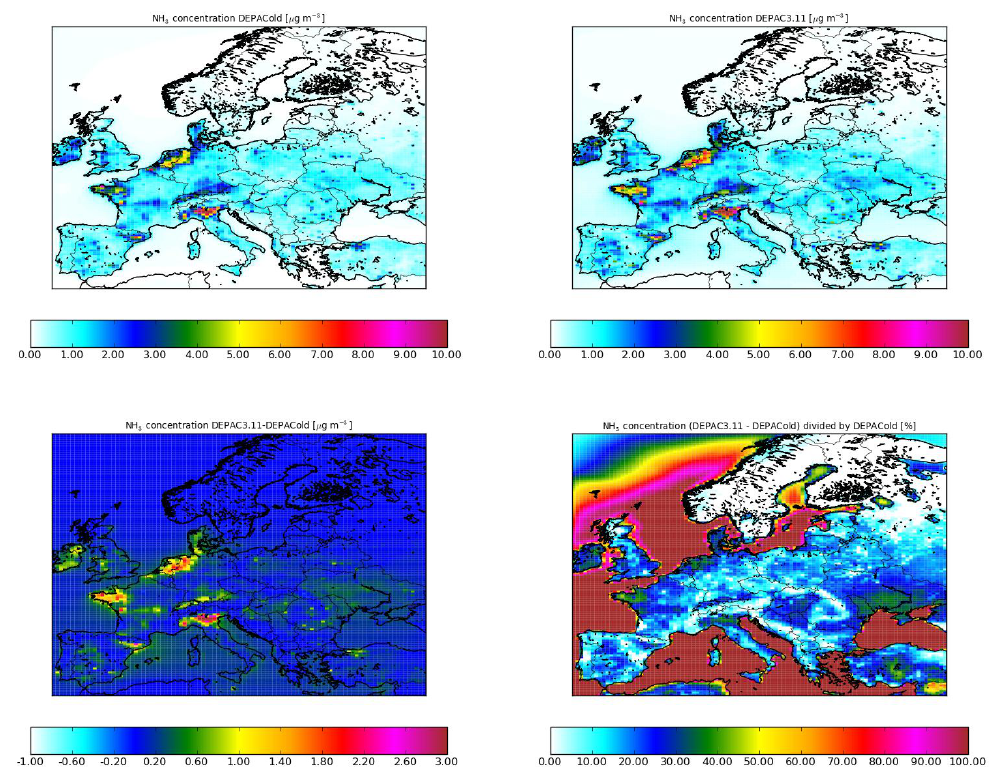
Fig. 3. The yearly mean NH 3 concentrations as calculated by the LOTOS-EUROS model with the DEPACold (upper left) and DEPAC3.11 Figure 3. The yearly mean NH concentrations as calculated by the LOTOS-EUROS model with the 3 module (upper right) for the year 2007. The lower left figure shows the absolute difference, and the lower right figure shows the relative 'DEPACold' (upper left) and 'DEPAC3.11' module (upper right) for the year 2007. The lower left difference between the two model calculations. The grid resolution in these figures is 0.50 ◦ longitude × 0.25 ◦ latitude ( ∼ 28 × 28km 2 )